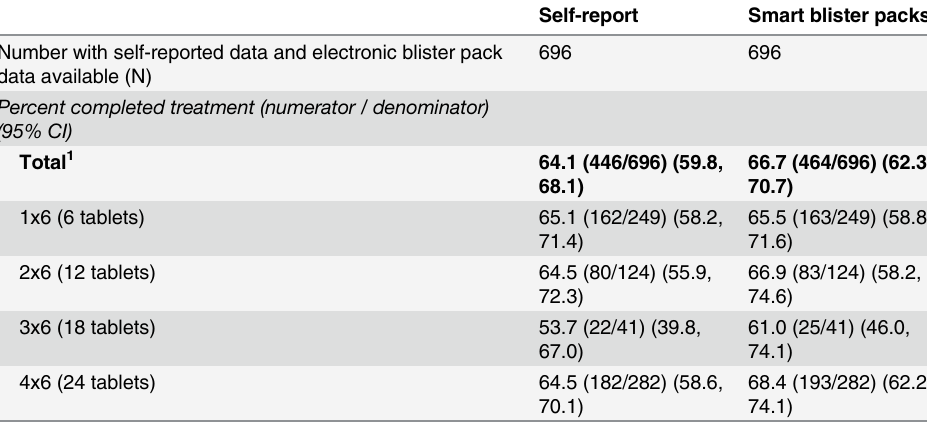
Table 2. Completed treatment by self-report and smart blister